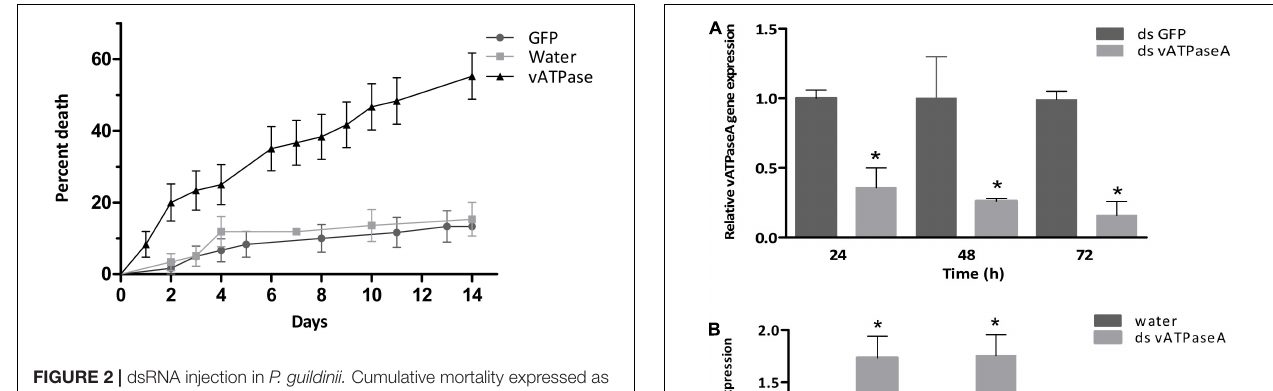
FIGURE 2 | dsRNA injection in P. guildinii. Cumulative mortality expressed as percentage in P. guildinii adults after injection with dsRNA (28 ng/ µ l per mg of body weight) targeting vATPase A , green fluorescent protein (GFP), or water. Error bars represent SE from two independent assays.